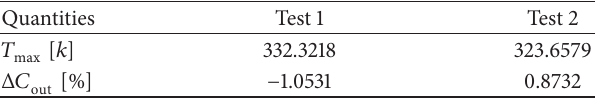
Table 2: Performance parameters of the control